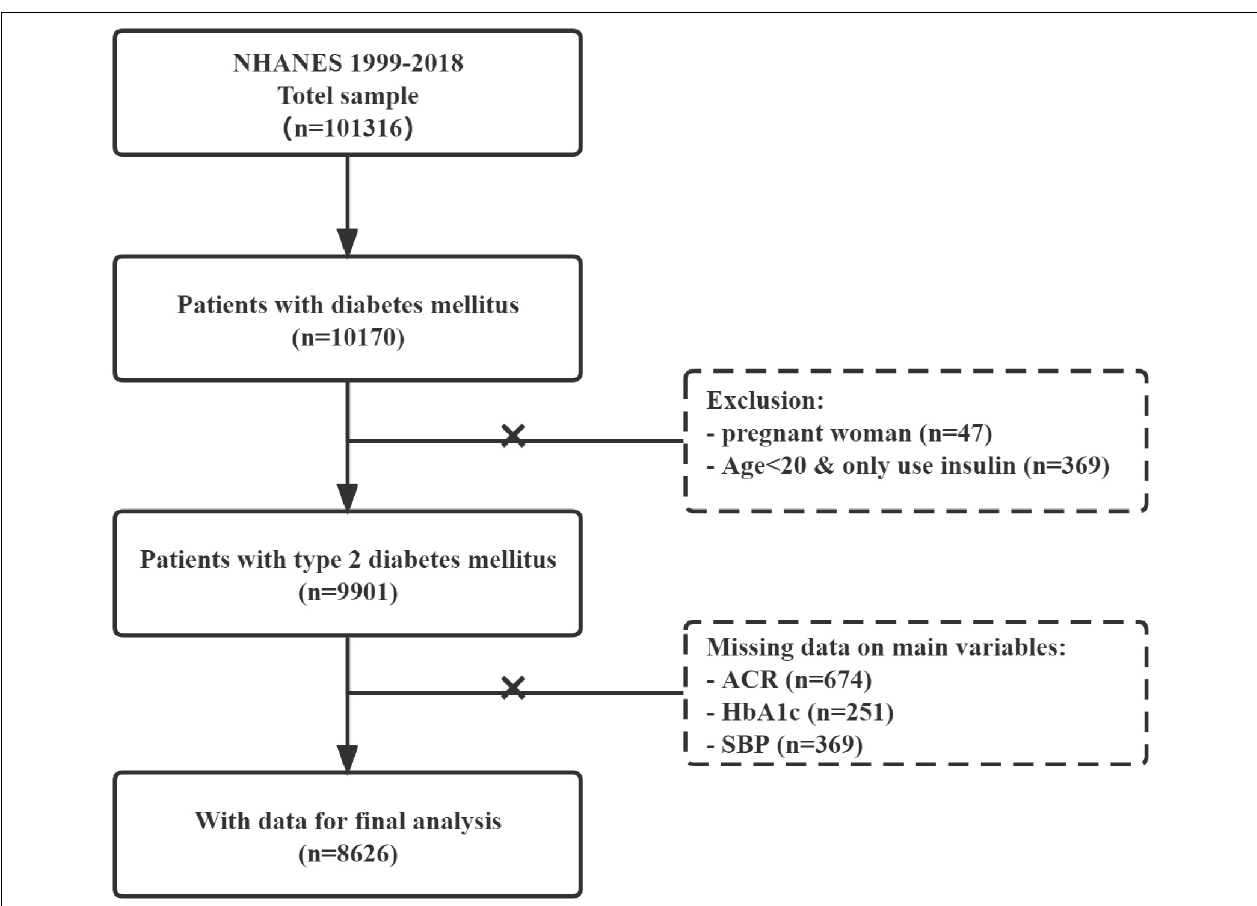
FIGURE 1 | Flow diagram of study population